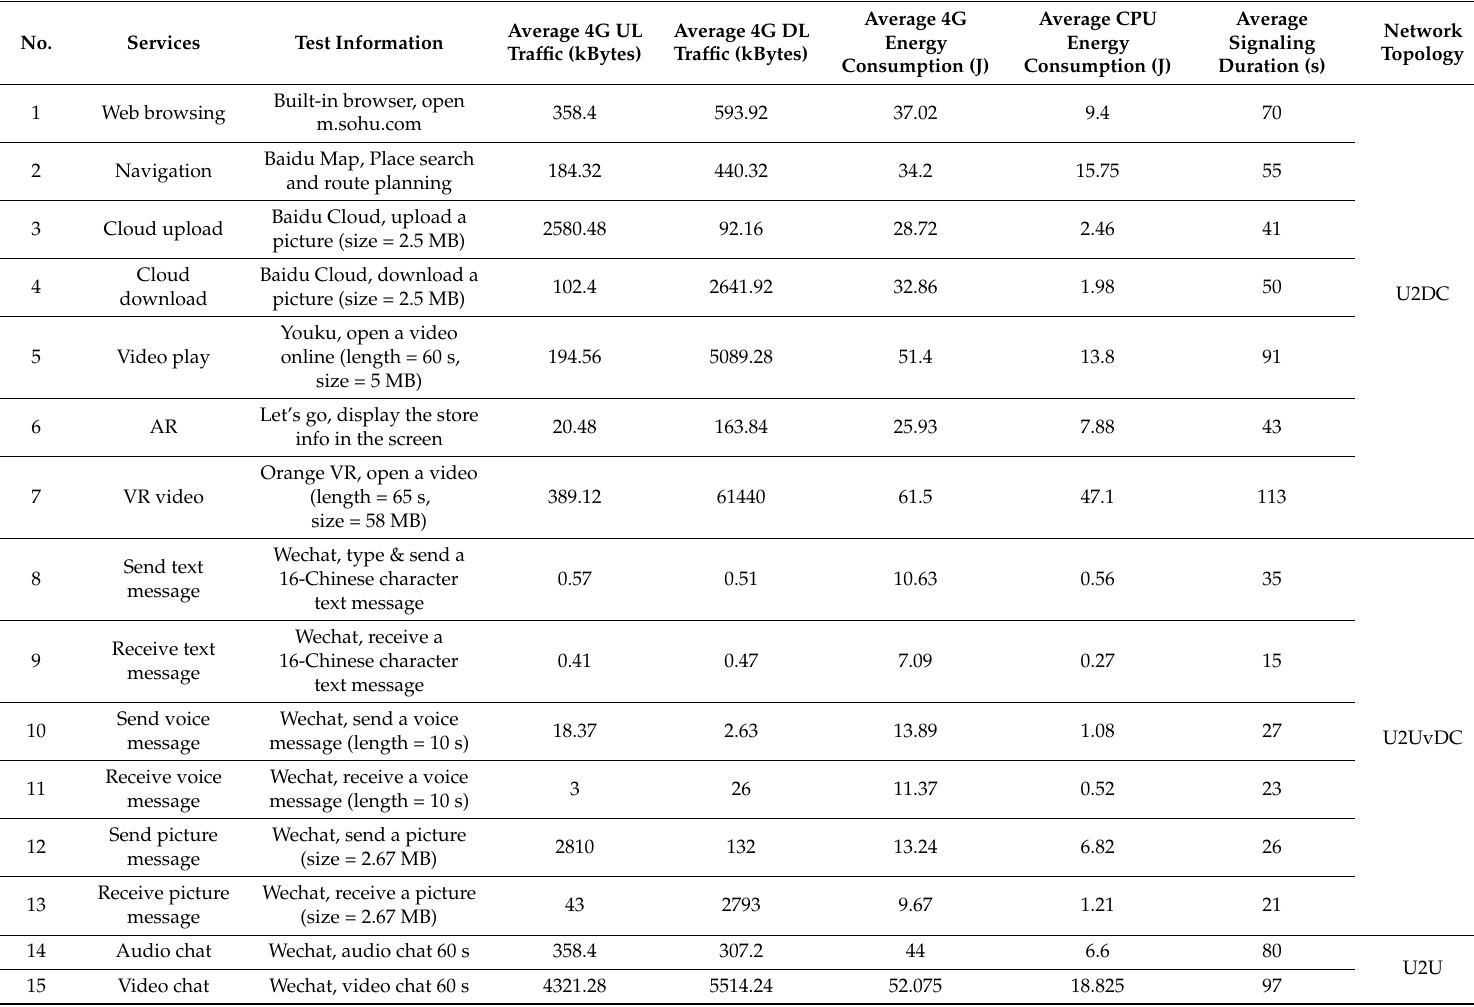
Table 1. Test results for the 15 mobile services under